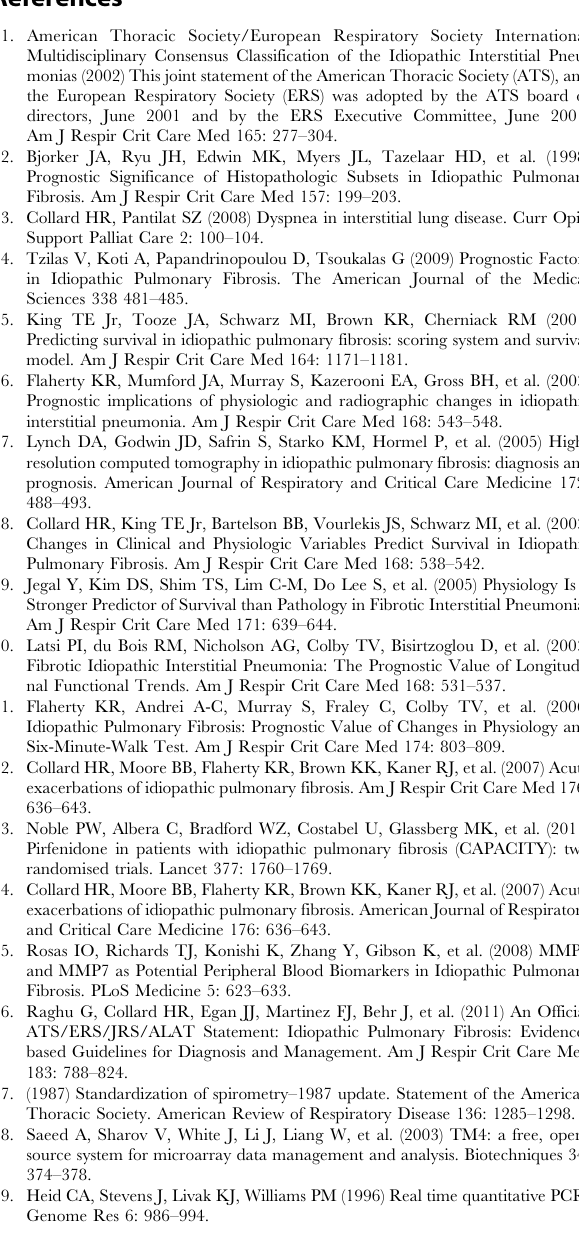
geneID number are presented. Fold change is log 2. FDR is false discover rate (%). (XLSX) Table S8 Validation of selected differentially-expressed genes by Reatime TM PCR. Primers utilized for PCR and differential expression by Realtime PCR using DD Ct method.